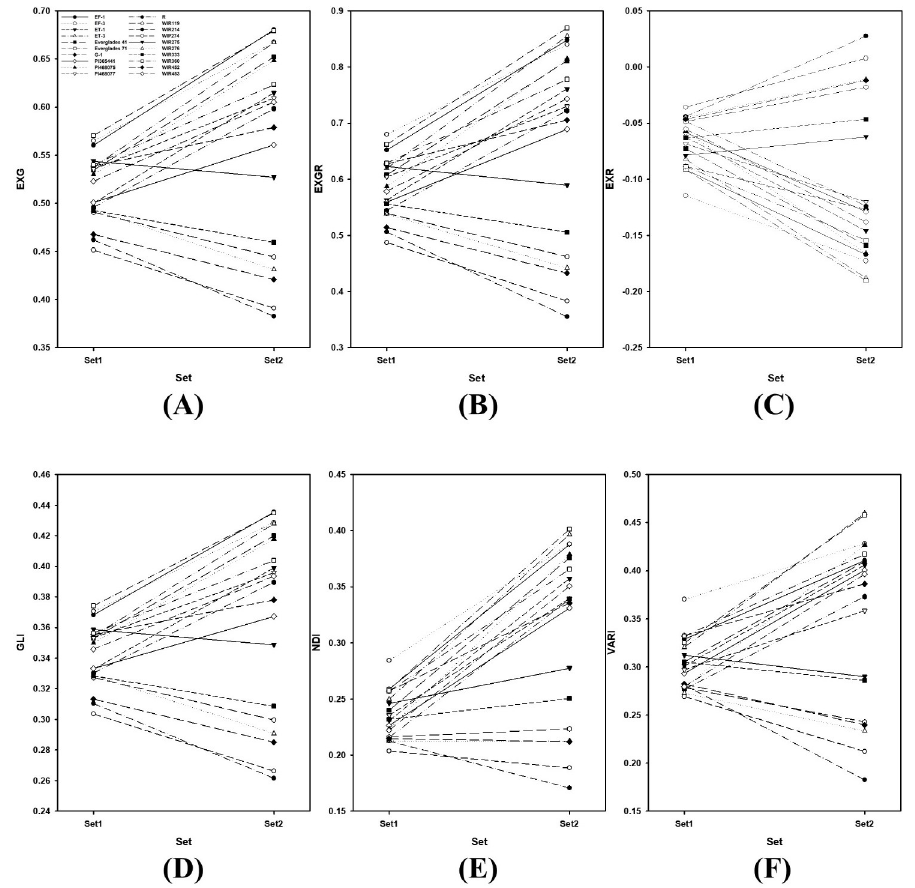
Fig 5. VIs of 20 kenaf entries at two different growth stages. (A) EXG, (B) EXGR, (C) EXR, (D) GLI, (E) NDI, and (F) VARI of 20 kenaf entries at two different growth stages. Set 1 and Set 2 measured June 22 and August